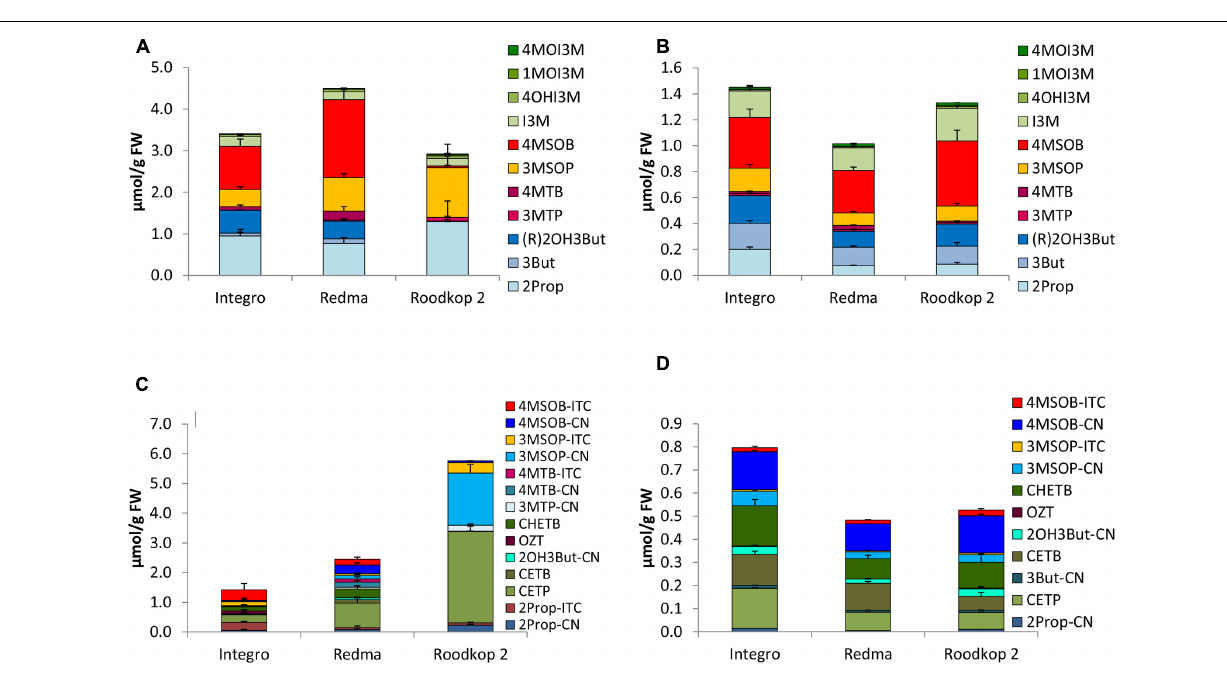
(CETB), 1-cyano-2-hydroxy-3,4-epithiobutane